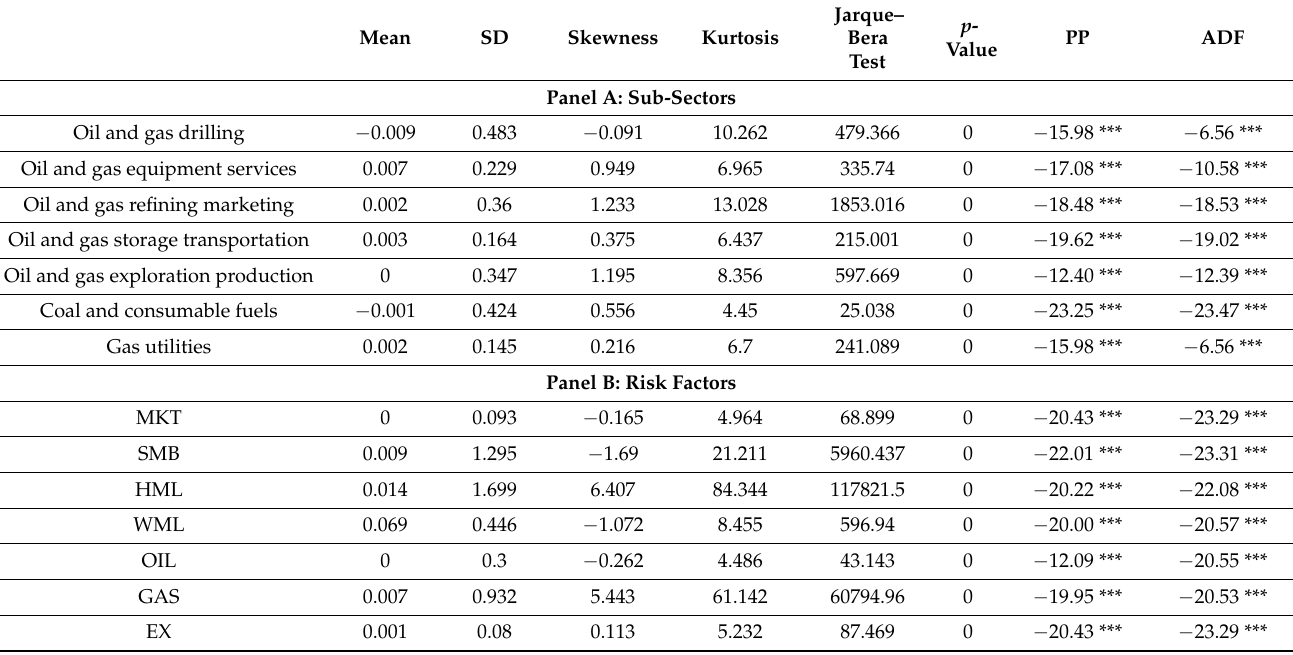
Table 2. Descriptive statistics, normality tests, and unit